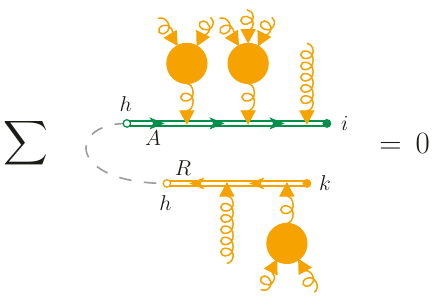
Figure 12 . Pictorial representation of the Ward identity (4.22) for the product of two Wilson lines. The sum runs over all possibilities to couple the gluons to the eikonal lines, either directly or via vertices V ( m )